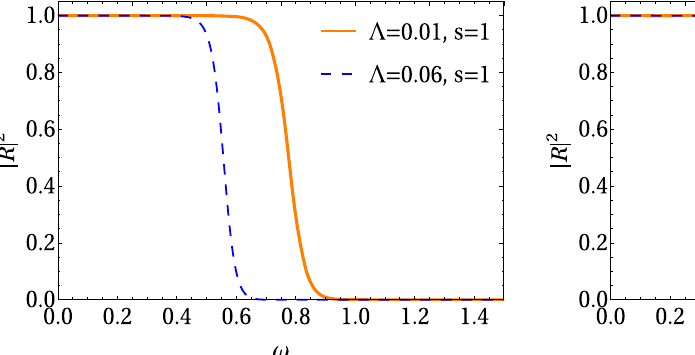
Fig. 19 | R | 2 vs ω for (cid:12) = 3 and q = 0 . 2 for different (cid:2) values